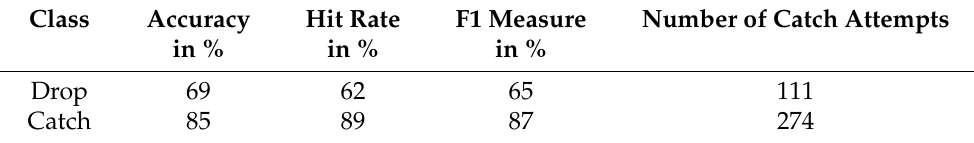
Table 3. Model assessment with the test dataset in audio classification.